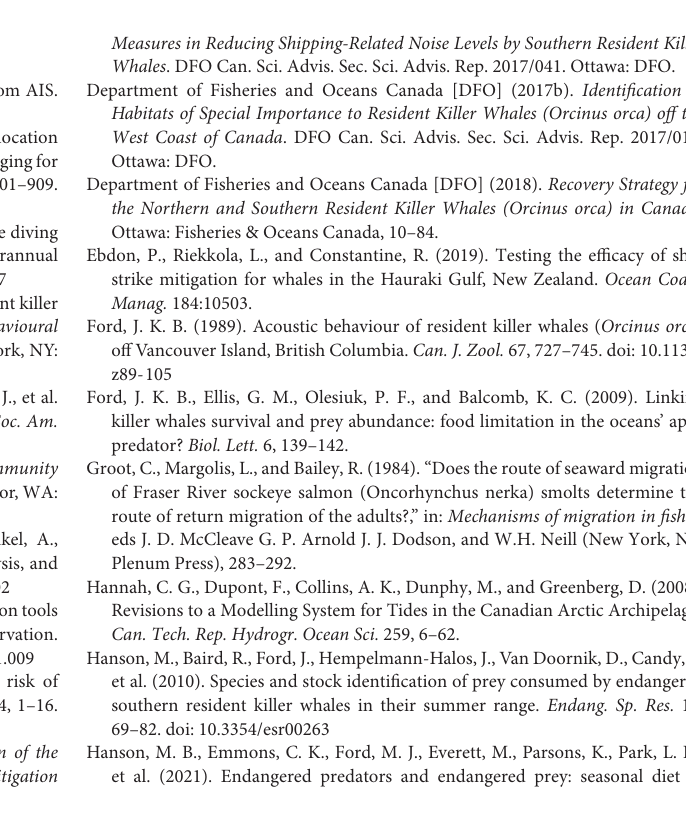
Supplementary Table 2 | Coordinates for the extents of the Interim Sanctuary Zones in 2020. Supplementary Table 3 | Comparison of sound pressure levels (SPLs) at the L 5 ,